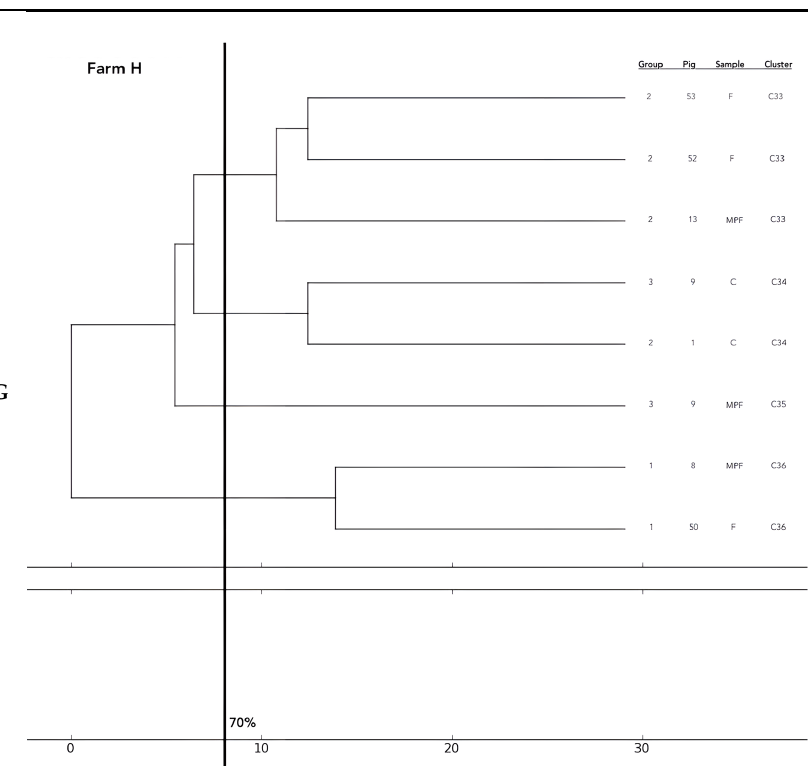
Figure 2. Phylogenetic relations of resistant E. coli highlighted in 11 pork food chains and 15 groups of food chain analysis (F = feces, C = carcasses, MPF = fresh meat product, MPFe = fermented meat product, MFS= seasoned meat product). Each subfigure (from ( A ) to ( G )) represent the phylogenetic E. coli similarities in the different pig farms selected.